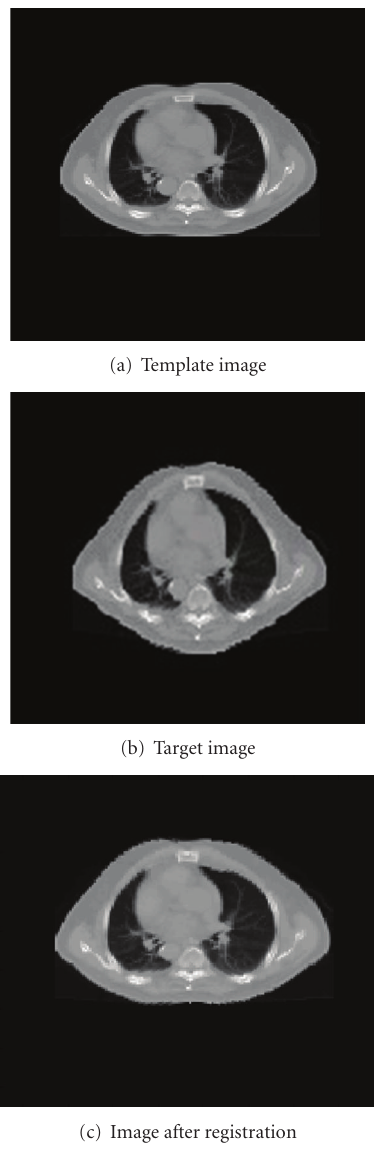
Figure 2: Registration result of a 2D digital